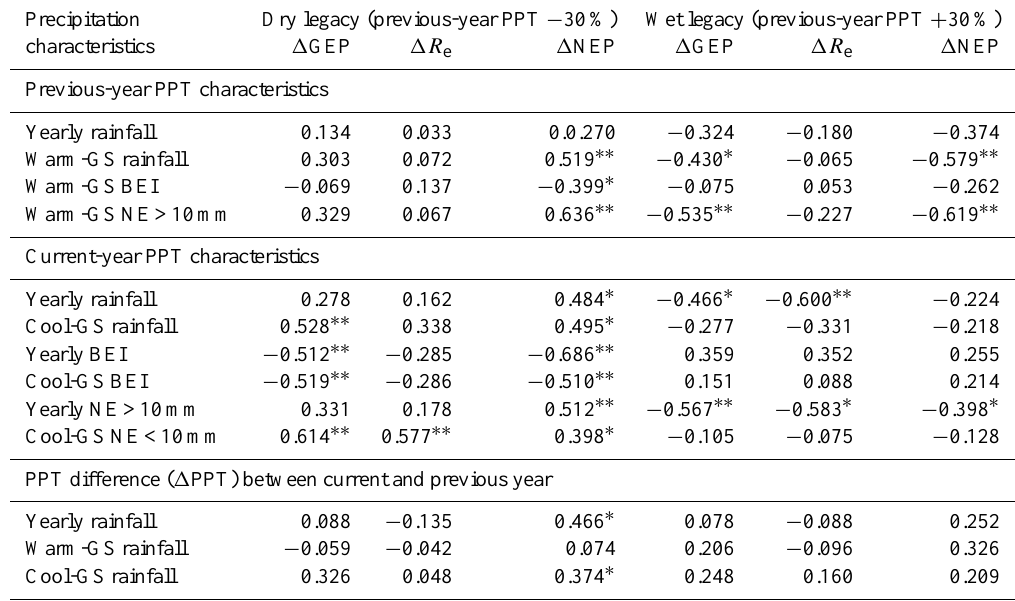
Table 1. Spearman correlation coefficients between interannual legacy effects and precipitation characteristics. Significant correlations are indicated with ∗ for 0.01< P ≤ 0.05 and ∗∗ for P ≤ 0.01 (2-tailed; n =